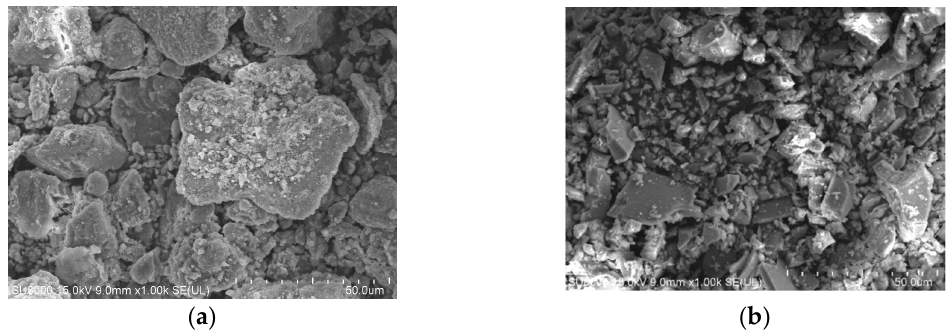
Figure 1. SEM images: ( a ) circulating fluidized bed (CFB) co-fired fly ash and ( b ) ground-granulated blast-furnace slag (GGBS).